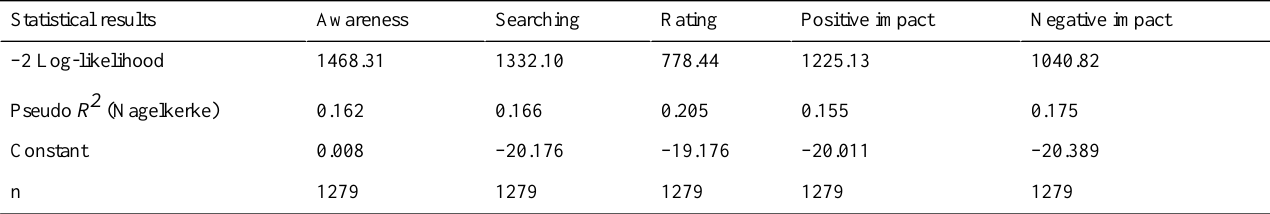
Table 4. Binary multivariate logistic regression analysis associated with physician-rating website relevant issues (unweighted sample).